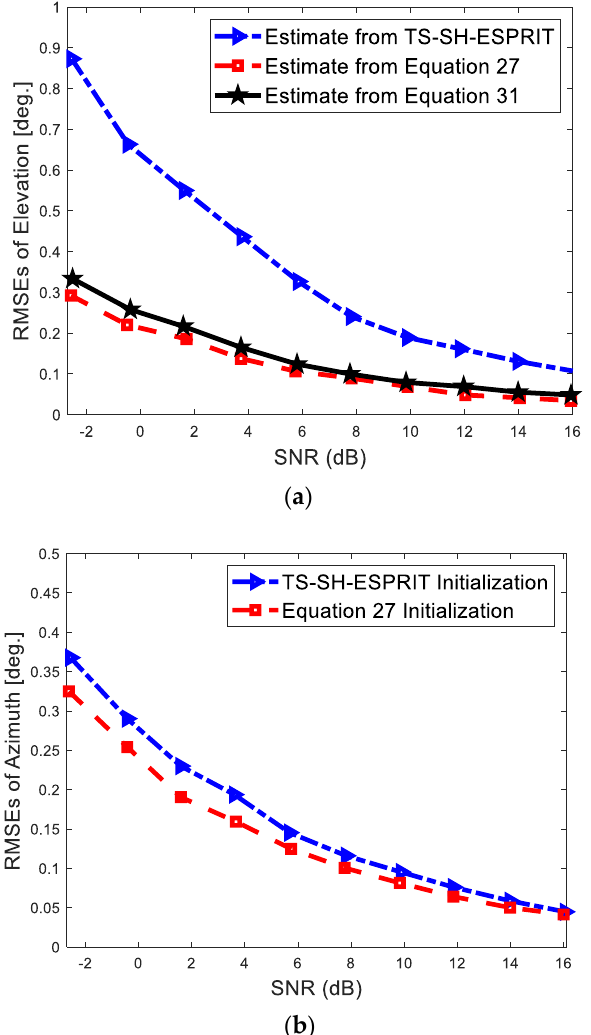
Figure 3. RMSEs of ( a ) elevation estimate; ( b ) azimuth estimate for various initialization with two sources.